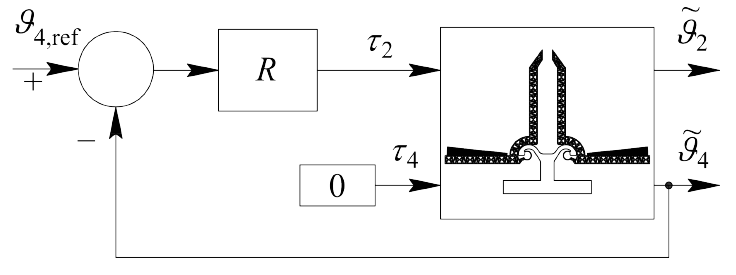
Figure 7. Control scheme adopted for evaluating stiffness k .